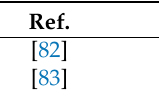
Table 5. Hybrid 3D Positioning Existing